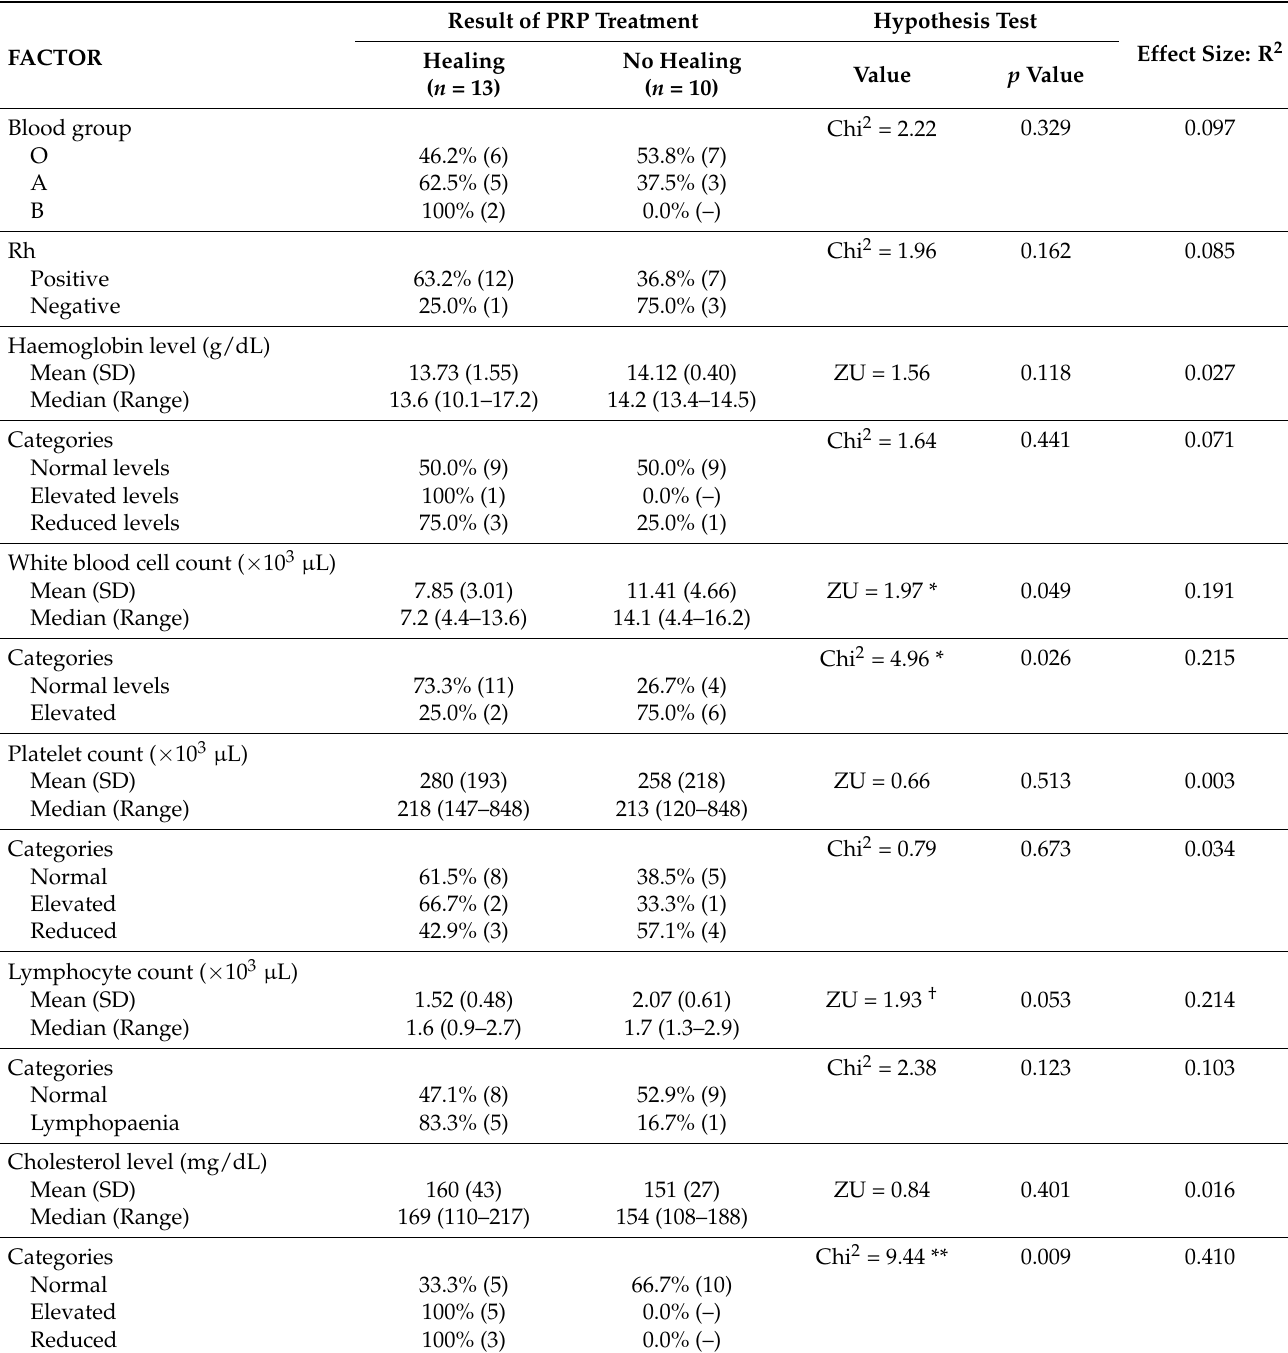
Table 4. Blood test result-related factors associated with wound healing in patients treated with PRP ( N = 23 CNHWs). Result of PRP FACTOR